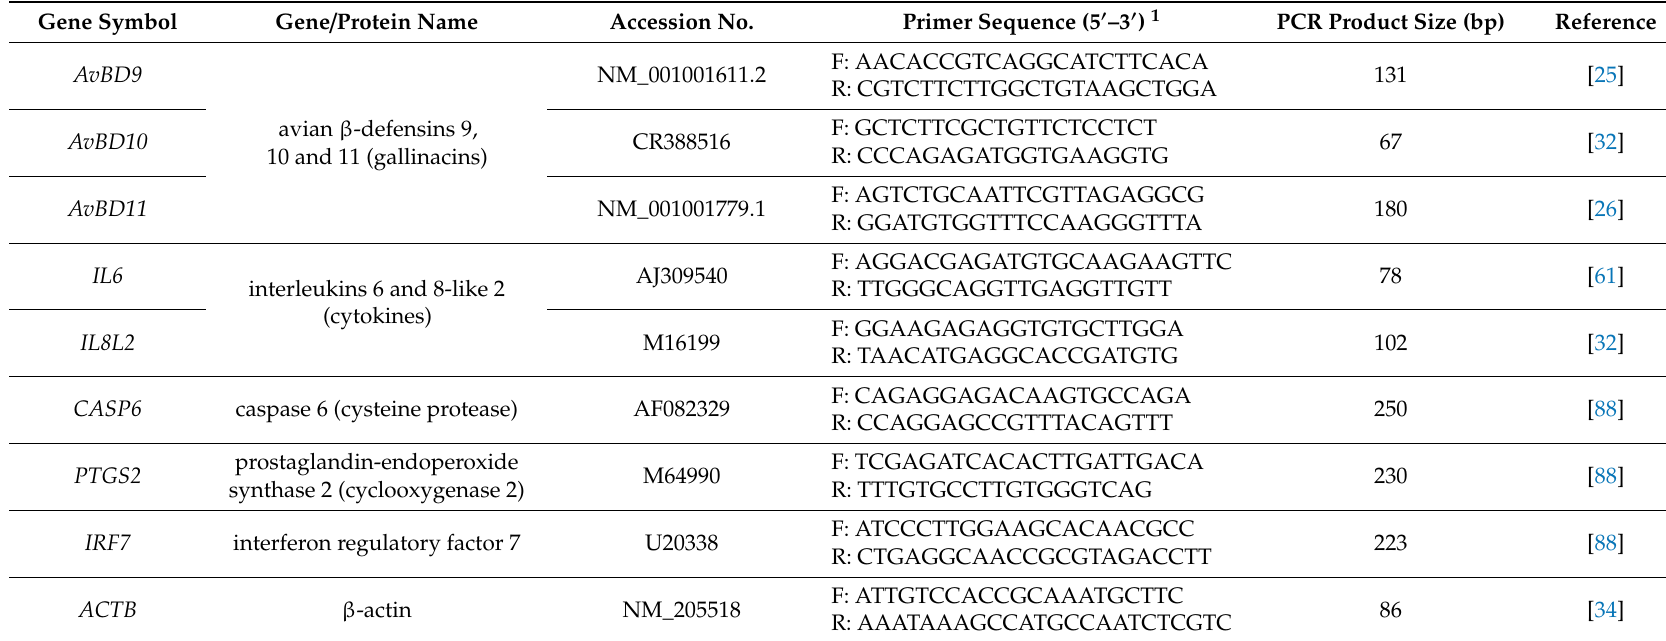
Table 1. Primers for assessing the expression of chicken genes involved in the immune